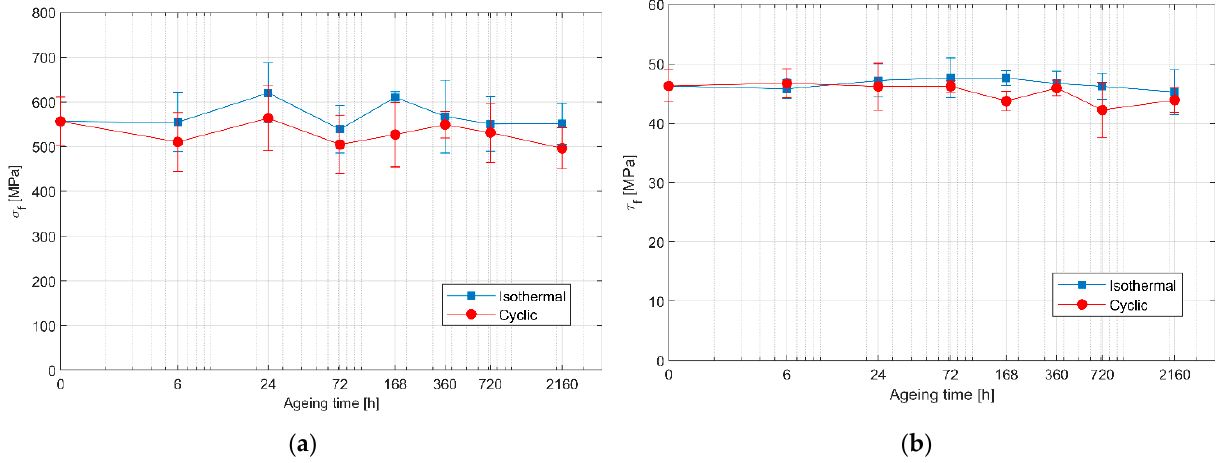
Figure 5. ( a ) Flexural strength and ( b ) interlaminar shear strength of cyclically aged specimens. The results for isothermal ageing at 90 °C are also reported for comparison.